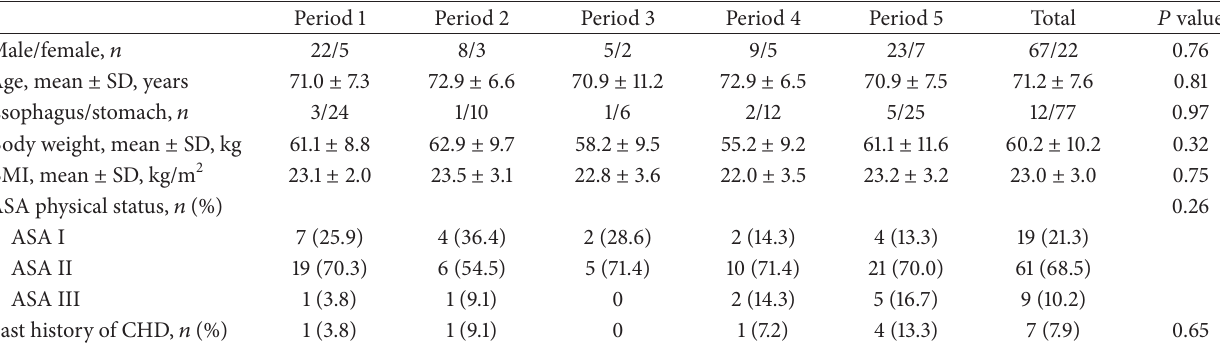
Table 1: Characteristics of study patients.